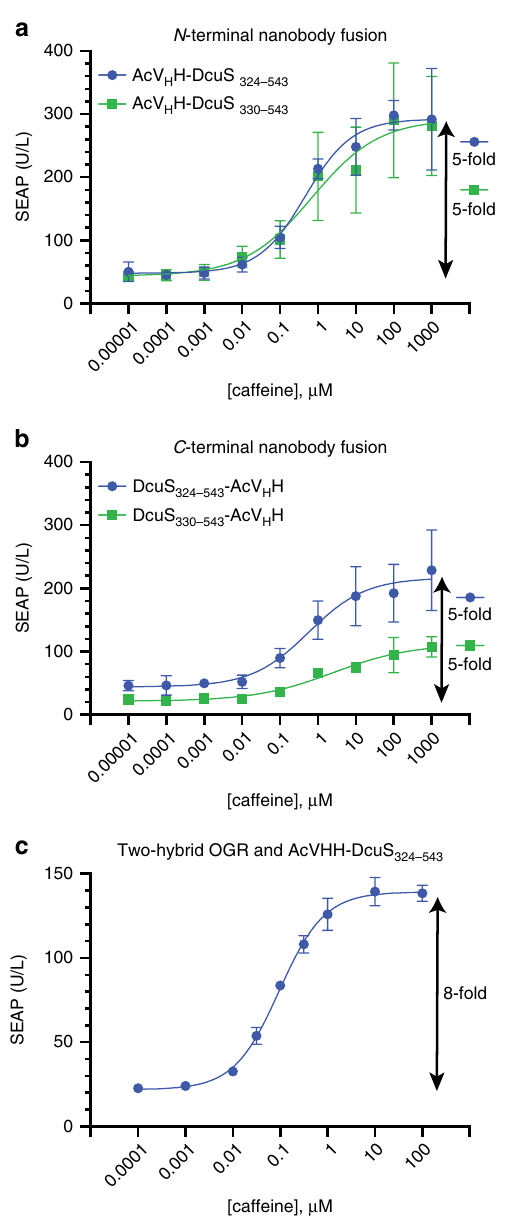
Fig. 5 Dose – response curves. a The dose – response curves of caffeine- induced reporter gene expression for POST with ORKs containing DcuS 324 – 543 or DcuS 330 – 543 fused to an N-terminal acV H H dimerization domain. b The dose – response curves for ORKs with a C-terminal acV H H dimerization domain. For better comparability with the performance of N-terminal acV H H fusion ORKs, the Y- axis has the same scale as panel a . c Dose – response of the two-hybrid OGR design and an acV H H-DcuS 324 – 543 ORK. Plots show the mean ± s.d. of n = 3 biologically independent samples measured 24 h after induction, and the results are representative of three independent experiments. Only error bars larger than the symbol size are displayed. Source data are provided as a Source Data fi